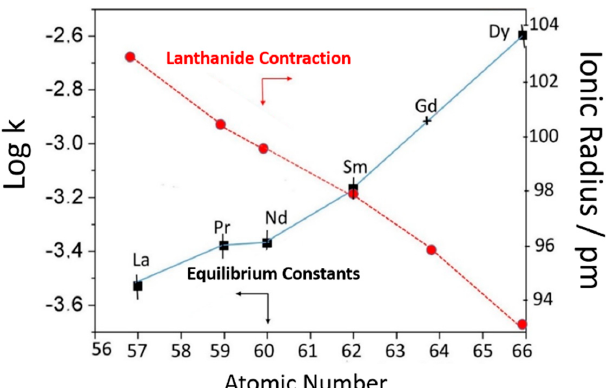
Figure 19. Affinity constants (K) of the lanthanide elements as a function of the atomic number, superimposed to the corresponding radial contraction plot (adapted with permission from [44]).